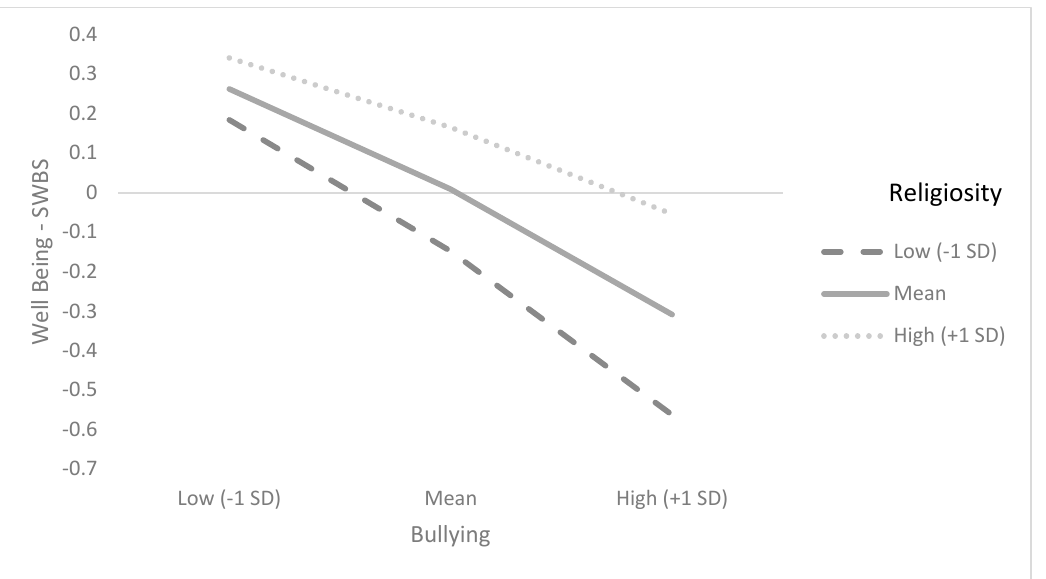
Figure 2. Interaction between child religiosity and bullying victimization in predicting SWBS.